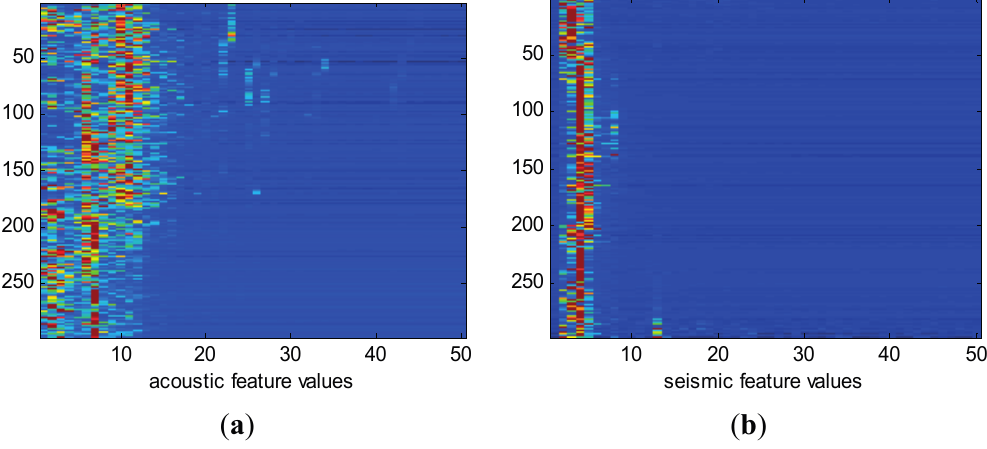
Figure 6. Image plot of extract features. Subplots ( a , b ) are features extracted from acoustic signals and seismic signals, respectively. The vehicle type is AAV and each of the subplots has 297